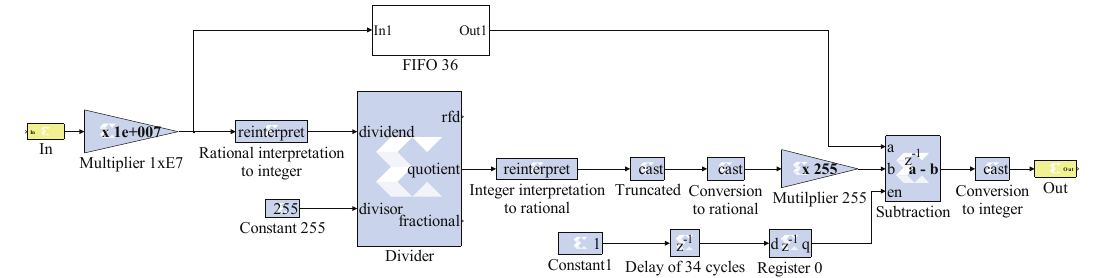
Figure 4. Operation mod ( 255 ) implemented in FPGA by using Simulink with SysGen